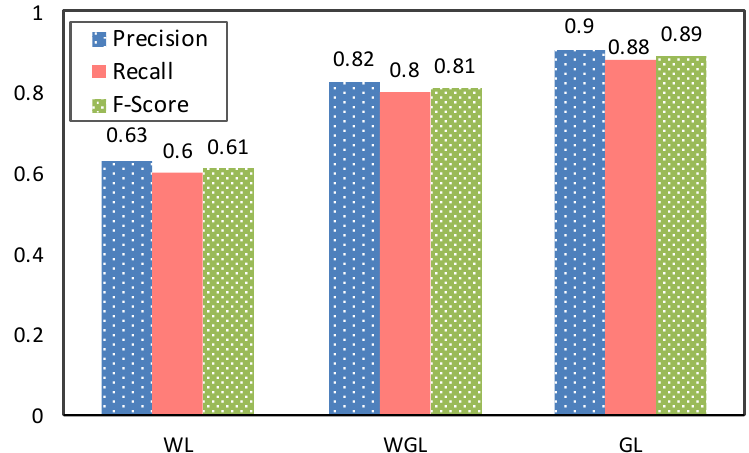
Figure 5. Accuracy of the three different location state estimation approaches based on available data type(s); Wifi Location (WL), Wifi/Geographic Location (WGL) and Geographic Location (GL).